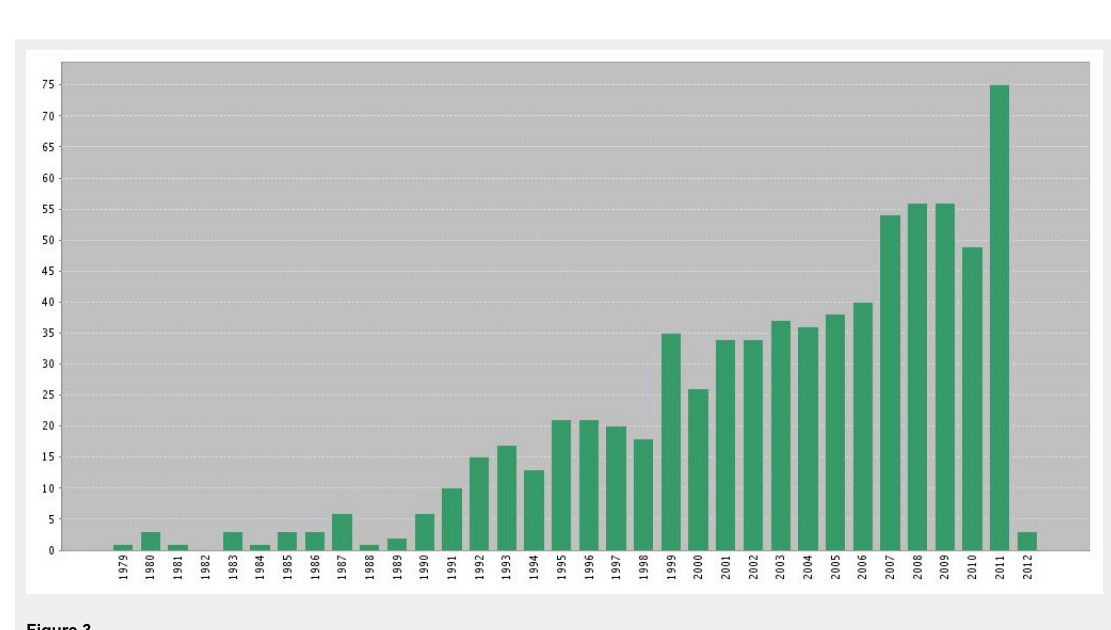
Figure 3 Referenced publications on ICU elderly patients’ outcomes. Data extracted from ISI Web of science, Web of Knowledge (2012). Key words: (“intensive care” OR “critical care” OR “icu”) AND elderly AND outcome. Results: 1,048